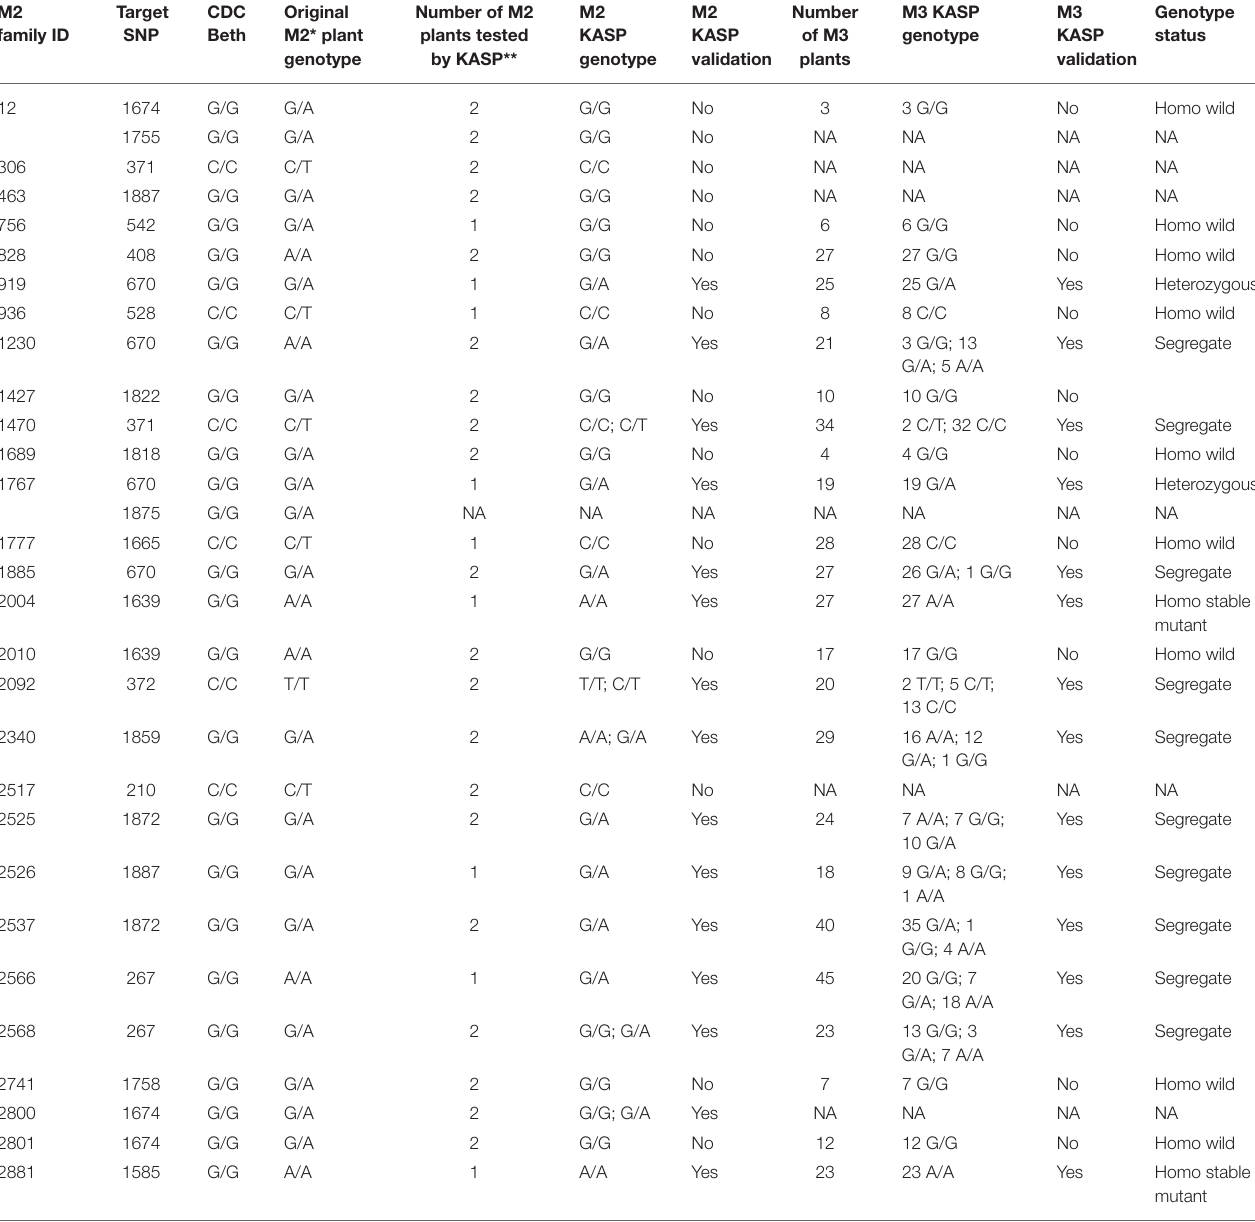
TABLE 4 | Mutation stability and segregation among seed from single flax bolls. M2 family